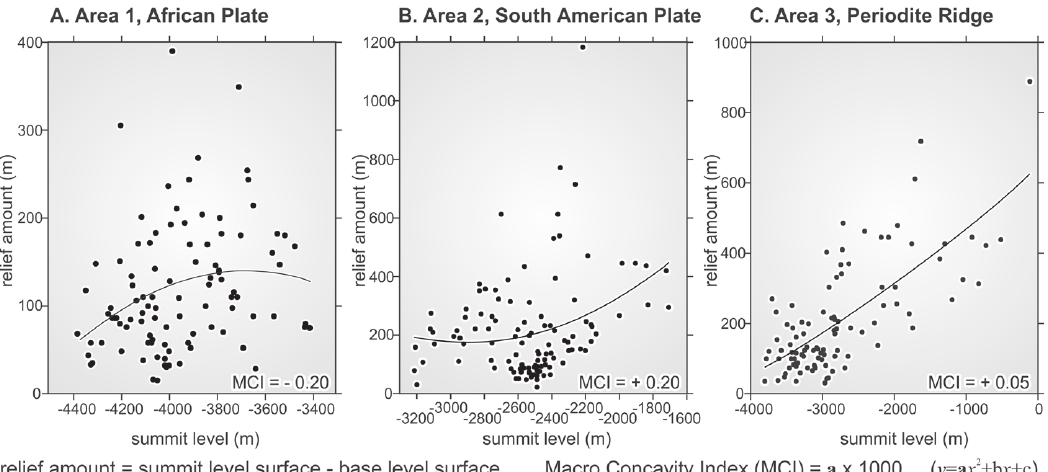
Figure 16 - MCI diagrams based on the summit level and base level surface of the grid interval of 7.5 km for the areas of : A) Mid-ocean ridge and breakaways in the African Plate, rectangular area 1; B) Abyssal fracture zone in the South American Plate, rectangular area 2; C) Saint Peter and Saint Paul Peridotite Ridge, rectangular area 3. The localities of the rectangular data areas 1, 2, and 3 are shown on Figure